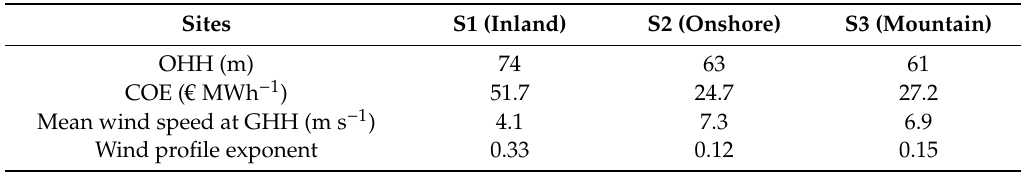
Figure 6. COE curves by hub height and OHH (points) at the three sites. ( a ) S1; ( b ) S2 and S3. Table 5. Comparison of the calculated results at the three sites. OHH, optimal hub height; GHH, general hub height.